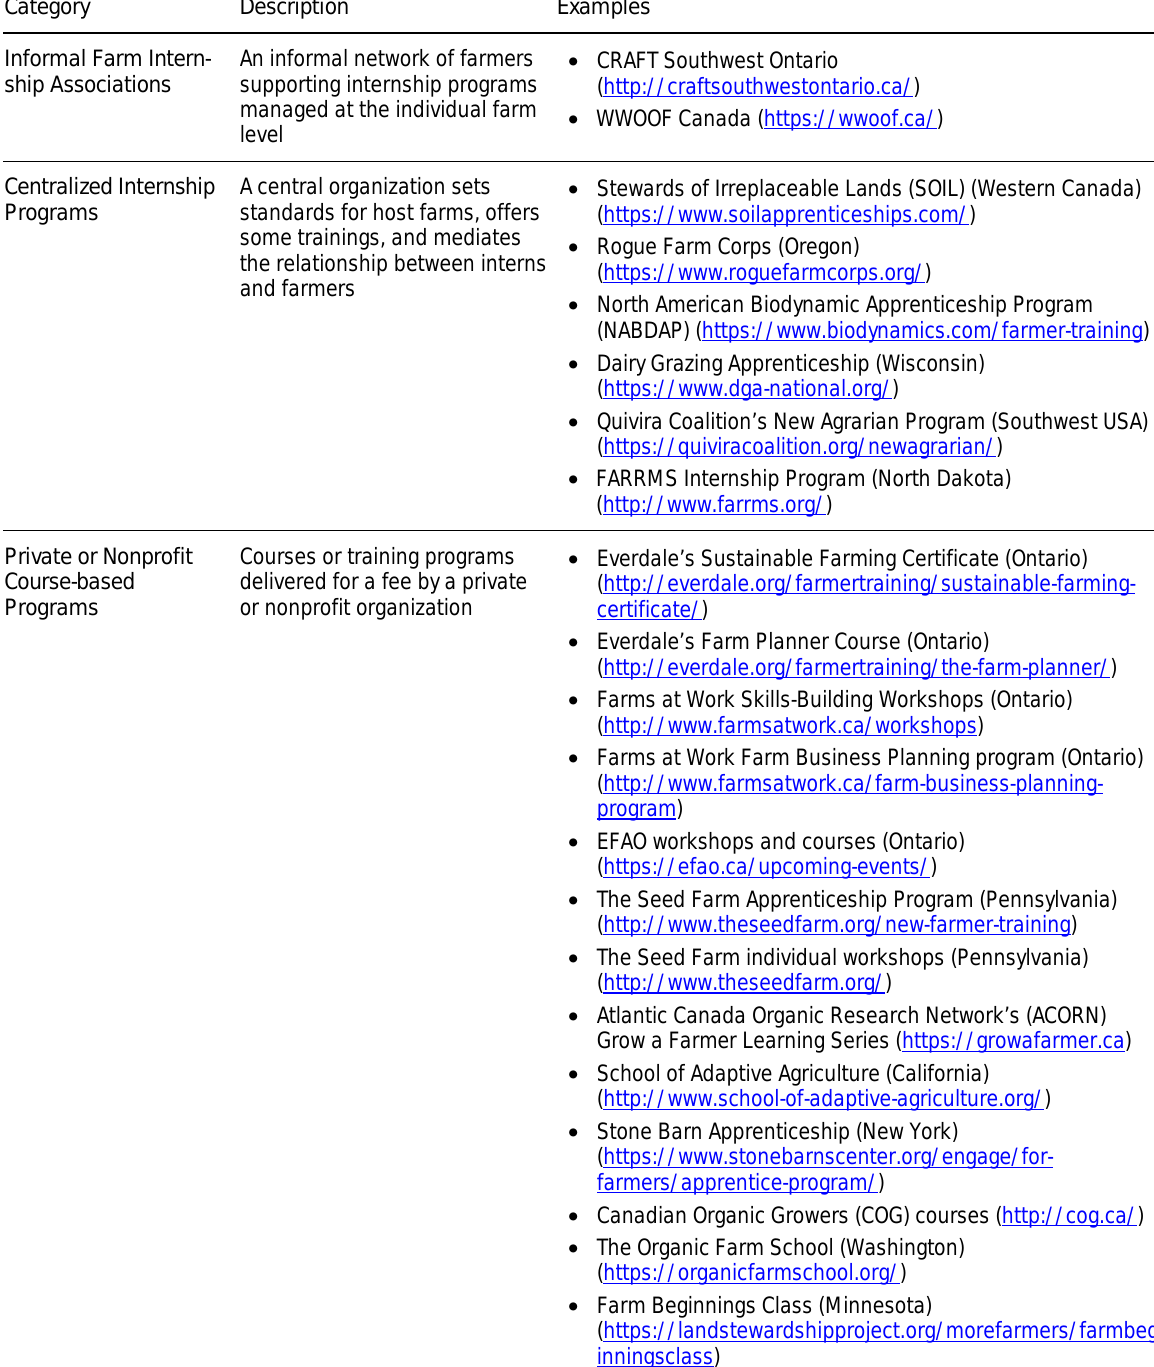
Table 1. Categories of Practical Farmer Training